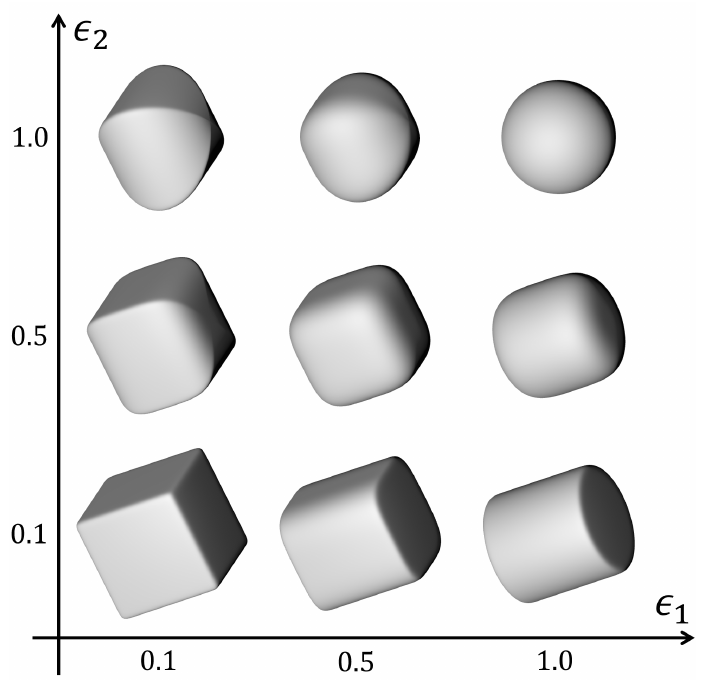
Figure 2. Possible superquadric shapes obtained by changing the shape parameters (cid:101) 1 and (cid:101) 2